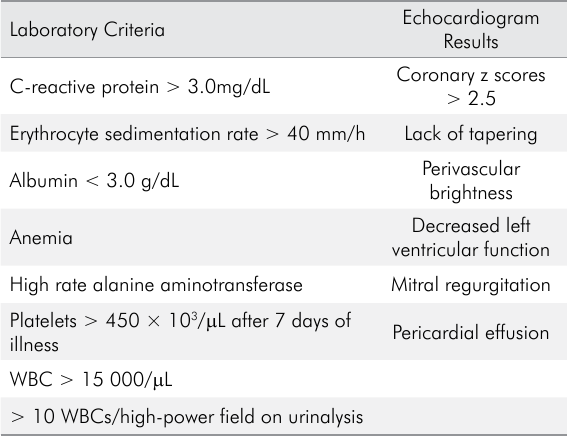
Table 3. Laboratory test and imaging results incorporated by American Heart Association for diagnosis of incomplete Kawasaki